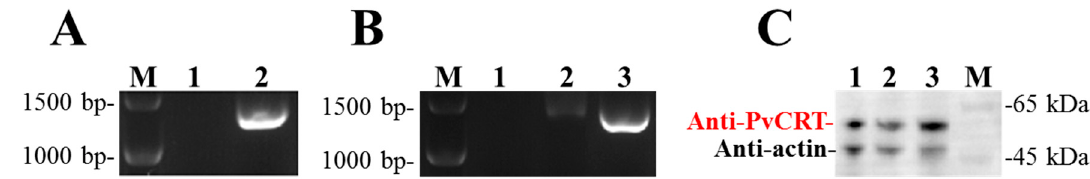
Figure 6. The expression of PvCRT in transgenic Drosophila . ( A ) The detection of PvCRT in pupal Drosophila by PCR. The temples of Drosophila genomic DNA were listed as follows: lane 1: WT, lane 2: UAS-PvCRT, M: DNA Ladder. ( B ) Validation of transcribed PvCRT in pupal Drosophila , cDNA temples were listed as follows: lane 1: Cg / WT, lane 2: WT / UAS-PvCRT, lane 3: Cg > UAS-PvCRT, M: DNA